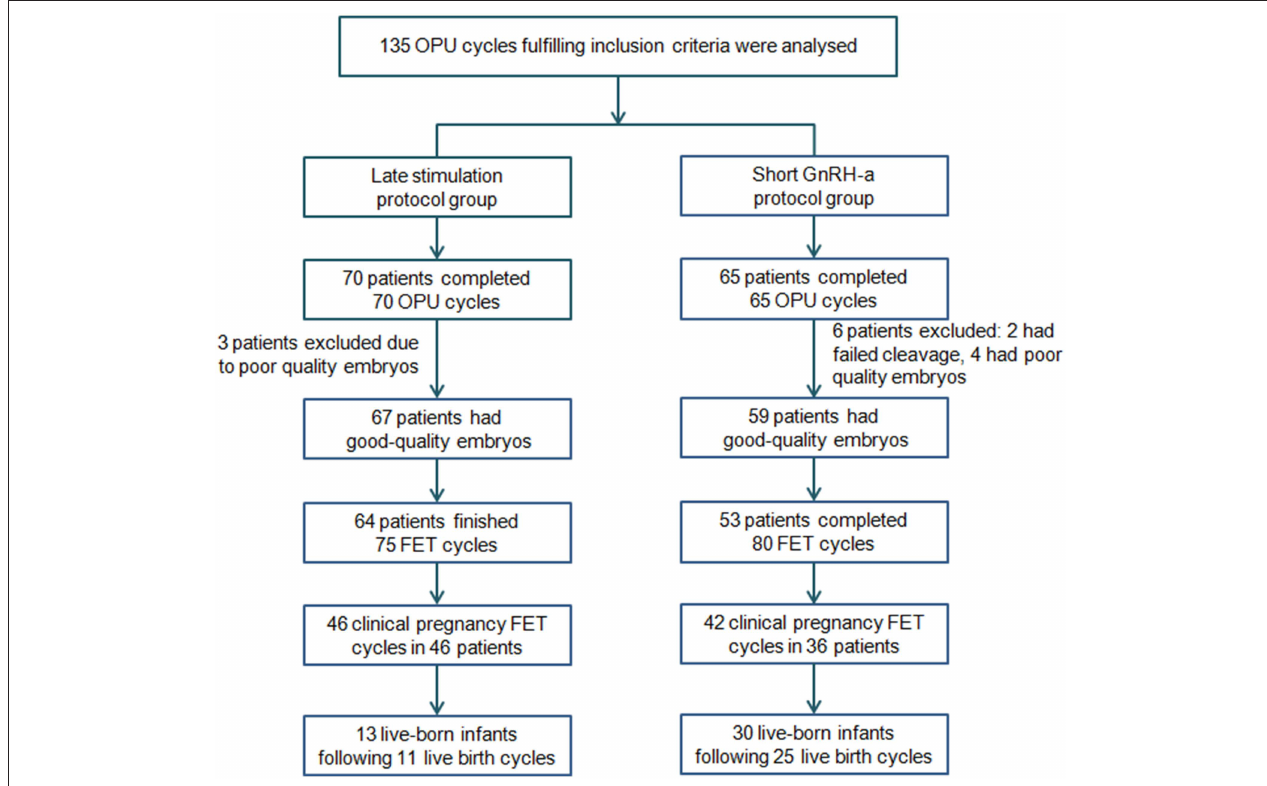
FIGURE 2 | Flowchart of the study. FET, frozen-thawed embryo transfer; GnRH-a, Gonadotropin-releasing hormone agonist; OPU, oocytes pick-up.